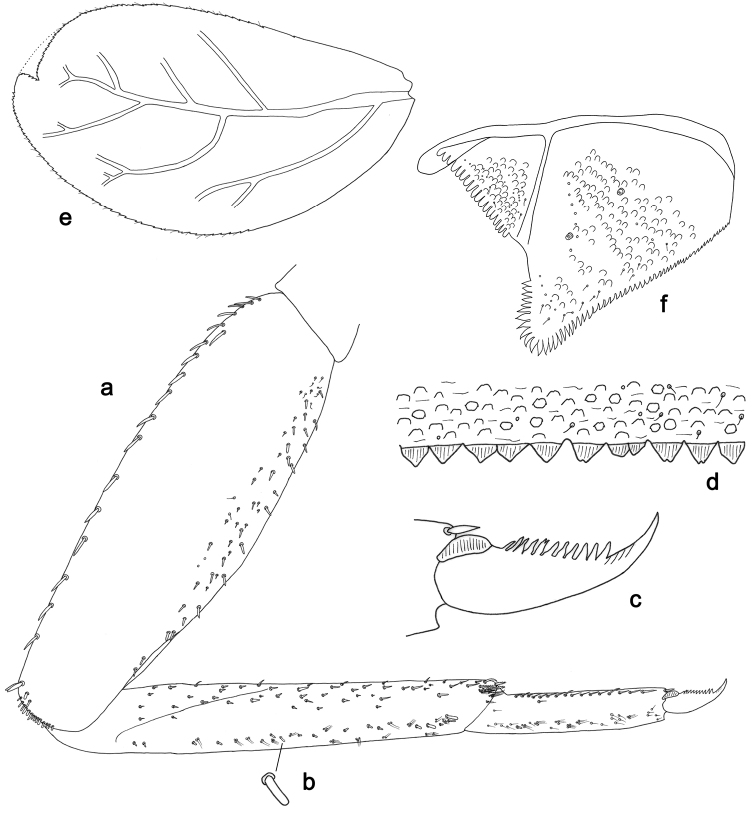
Labiobaetisbalkei sp. n., larva morphology: aForelegb Tibia dorsal seta c Fore claw dTergum IV e Gill IV fParaproct.